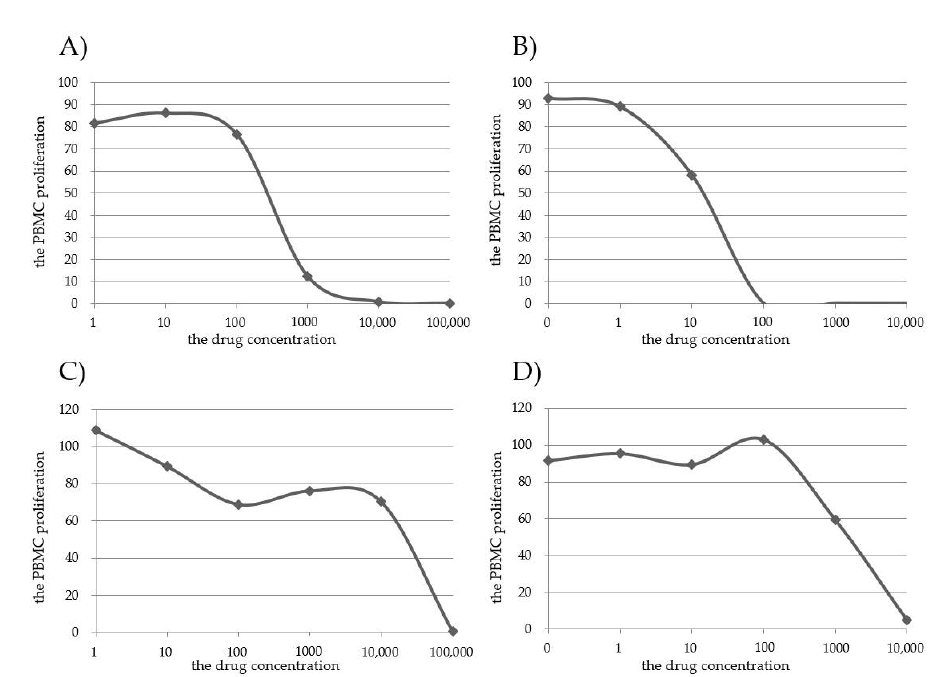
Figure 1. Examples of the concentration–response curve of the PBMC high and low sensitivity groups to GC. The concentration–response curve of the PBMC high-sensitivity group to COR ( A ) and to MPSL ( B ); the PBMC low-sensitivity group to COR ( C ) and to MPSL ( D